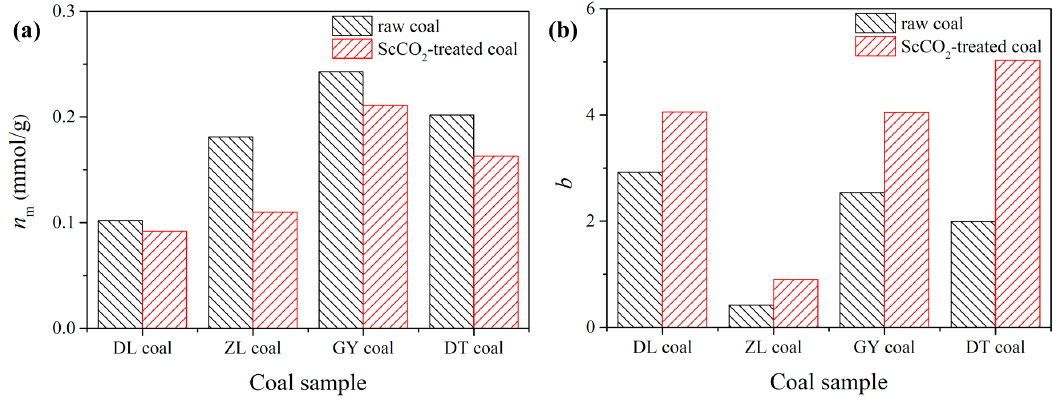
Figure 11. Fitting parameters for Langmuir model: ( a ) n m ; ( b ) b .